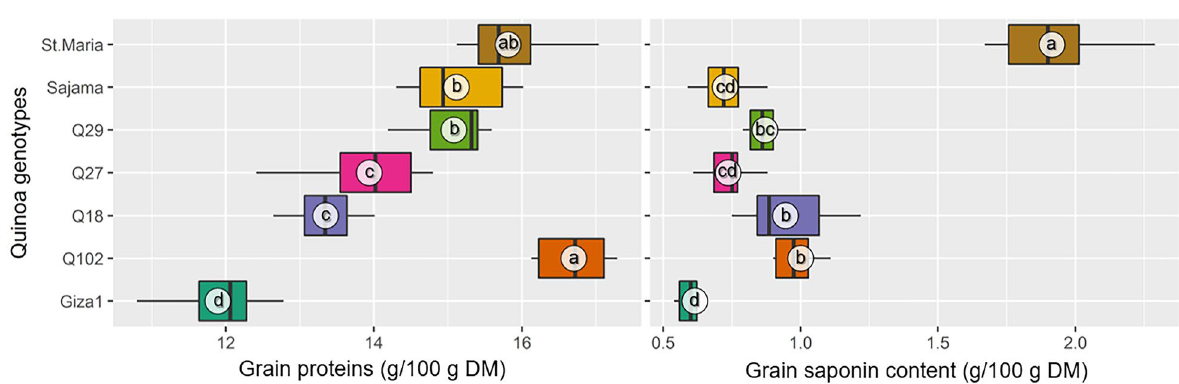
Figure 5. Boxplots displaying protein and saponin contents in the grains of seven quinoa genotypes grown in the Sahara Desert of Algeria. The same letters associated with mean values (white circles) are significantly not different ( p > 0.05) following Tukey’s post-hoc